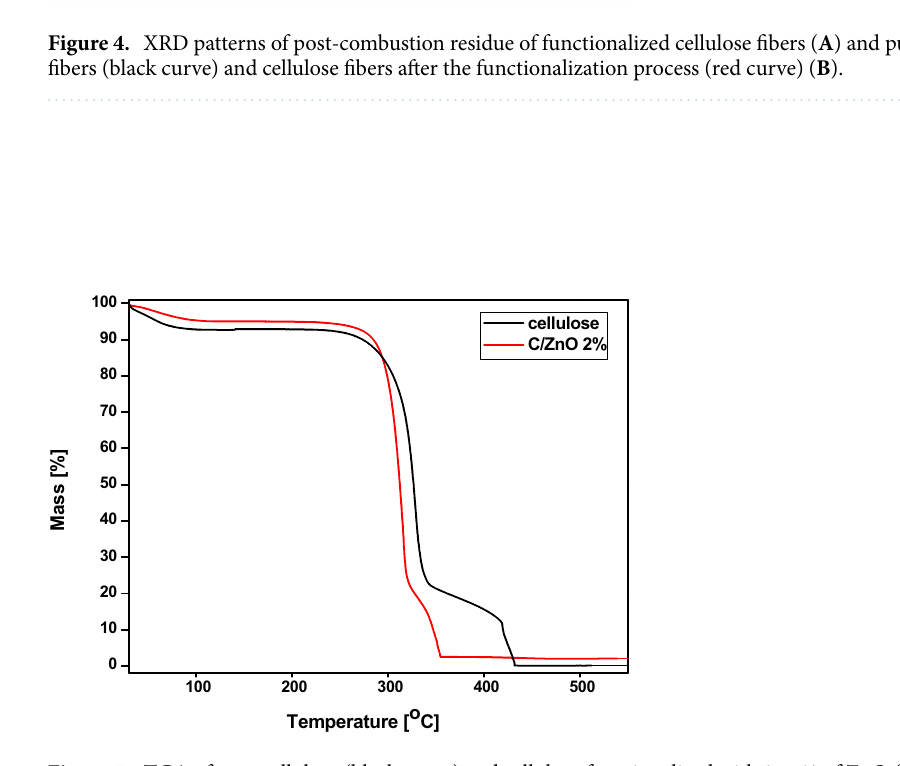
Figure 5. TGA of pure cellulose (black curve) and cellulose functionalized with 2 wt% of ZnO (red